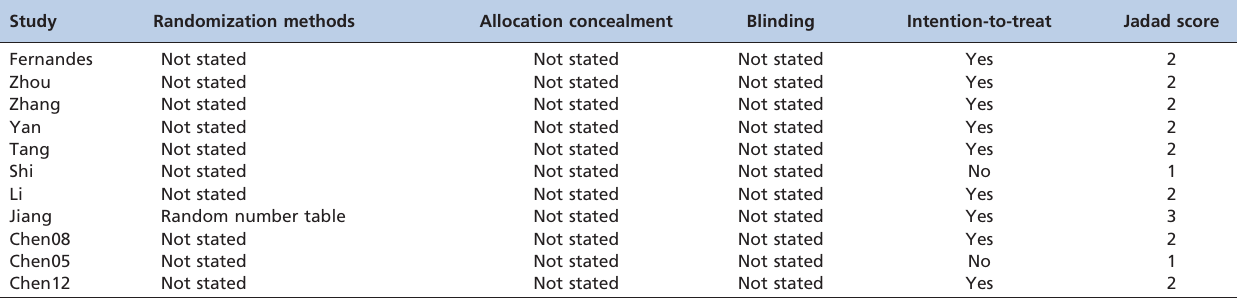
Table 3 - Methodological quality of the included studies. Study Randomization methods Allocation concealment Blinding Intention-to-treat Fernandes Not